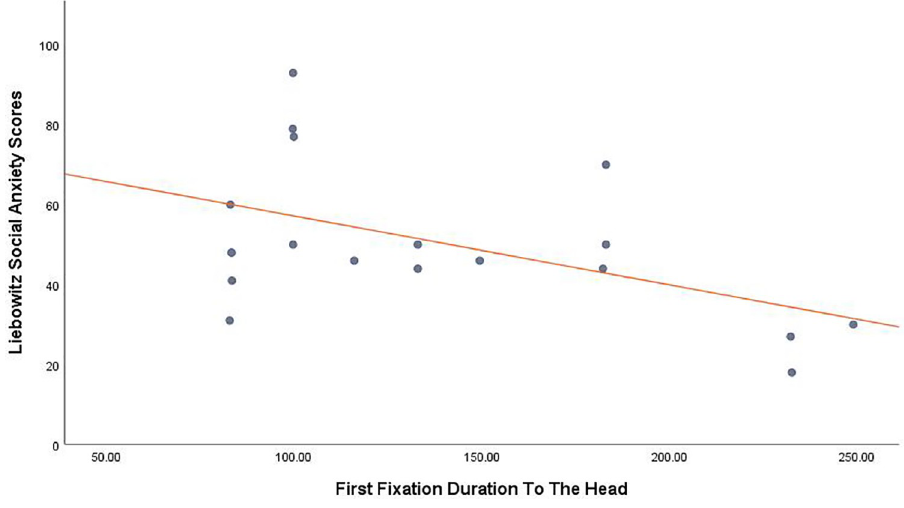
Fig 2. Scatterplot showing a correlation between first fixation duration to the head and SA traits.